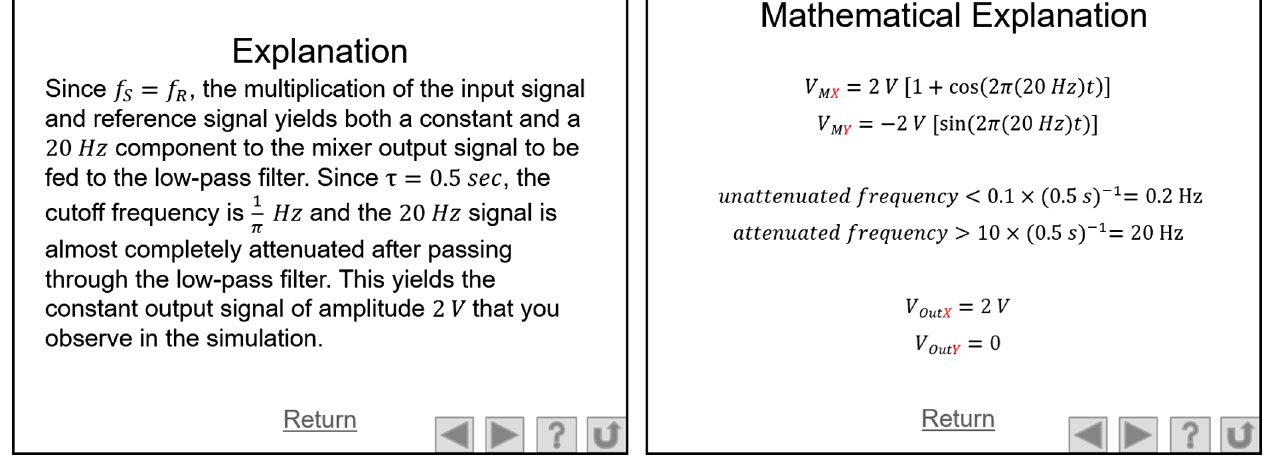
FIG. 2. Example of the explanations provided to students for each simulation (simulation 2 in this case). The “ explanation ” (left) features a conceptual description of the problem ’ s solution while the “ mathematical explanation ” (right) features the mathematics required to solve the problem.